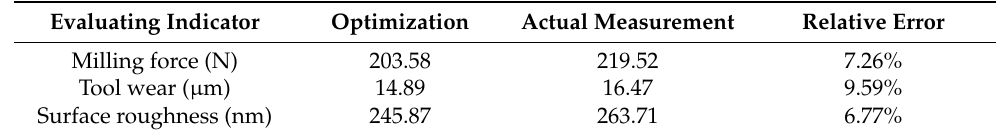
Table 9. Relative error of experimental